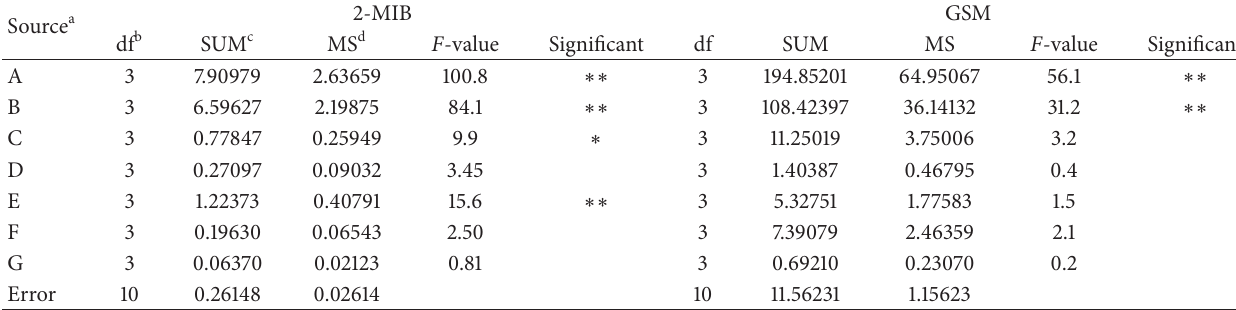
Table 5: The analysis of the variance of the main factors on the respective peak area of headspace volatile odors in simulated water samples.